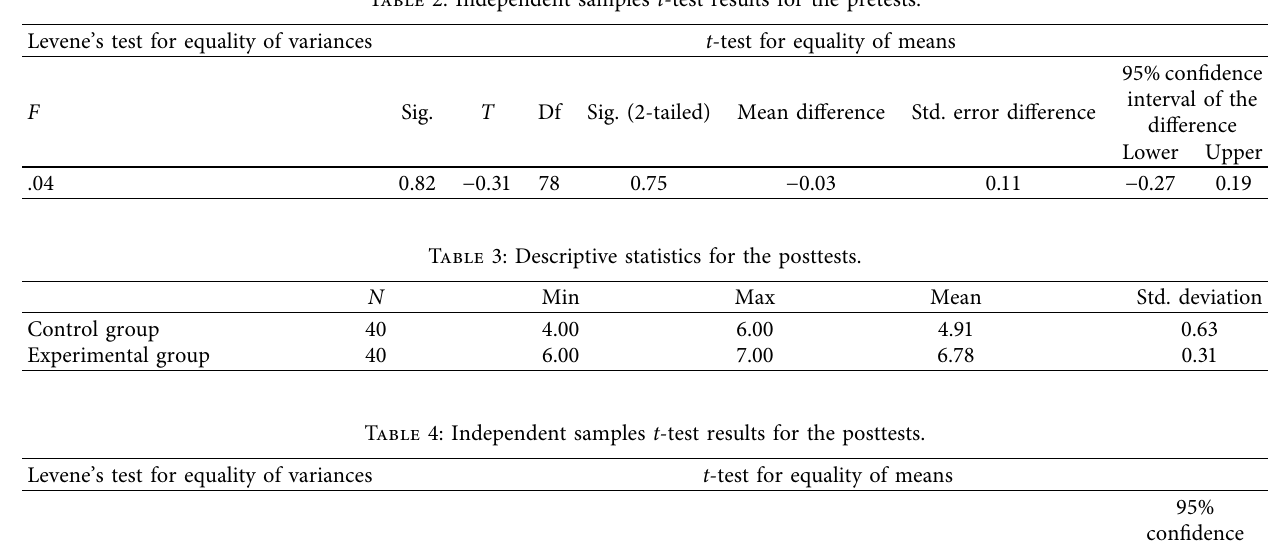
Table 2: Independent samples t -test results for the pretests.